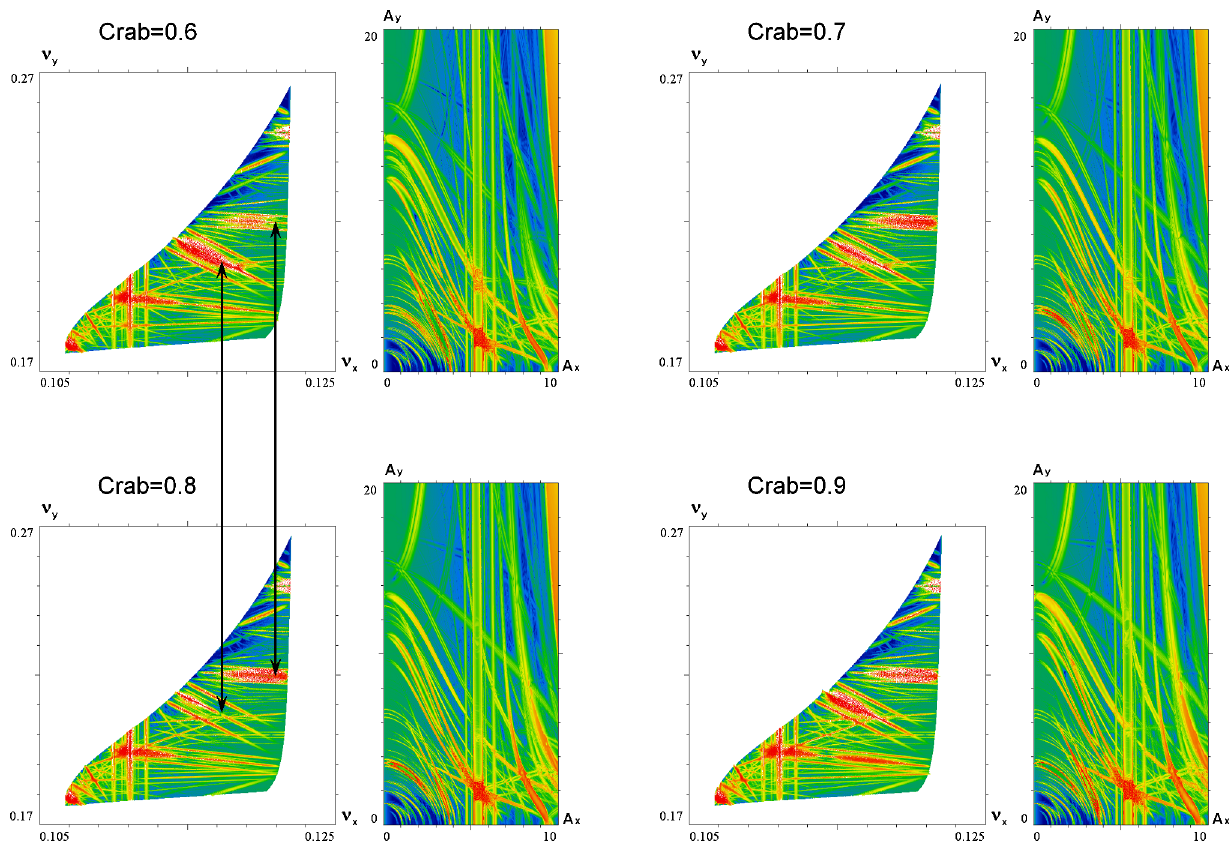
FIG. 8. Beam-beam resonances versus the crab value for DA(cid:1)NE (part 2).